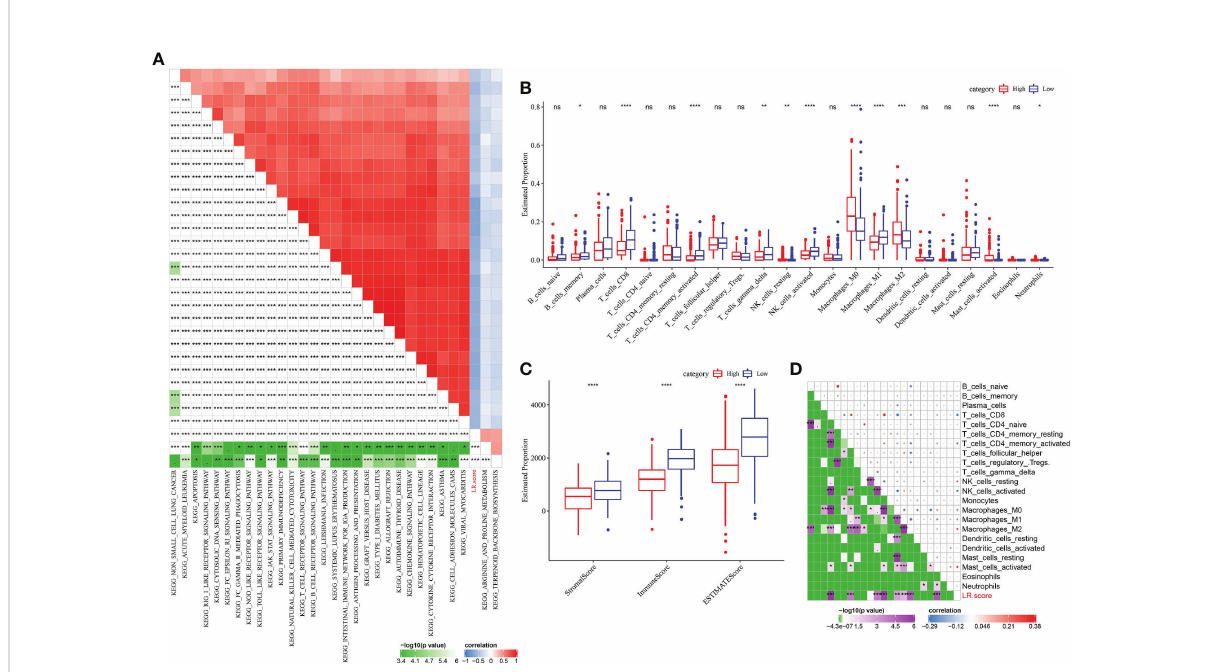
FIGURE 7 Correlation between LR pairs score and immune composition and immune-related pathways. (A) Pearson correlation analyses results between ssGSEA scores of KEGG pathways and LR score in METABRIC with |r|>0.4. (B) The box chart showing the relative abundance of the 22 immune cells in high- and low-LR pairs score groups in METABRICcohort, Wilcoxontest. (C) The box chart showing ESTIMATE immune scores of high- and low-LR pairsscoregroups in METABRIC cohort, Wilcoxontest. (D) Pearsoncorrelationanalysis of LR pairs scoreand immune cell components. The asterisksrepresented the statistical p value, *p< 0.05, **p < 0.01, ***p< 0.001, ****p < 0.0001,ns(no signi fi